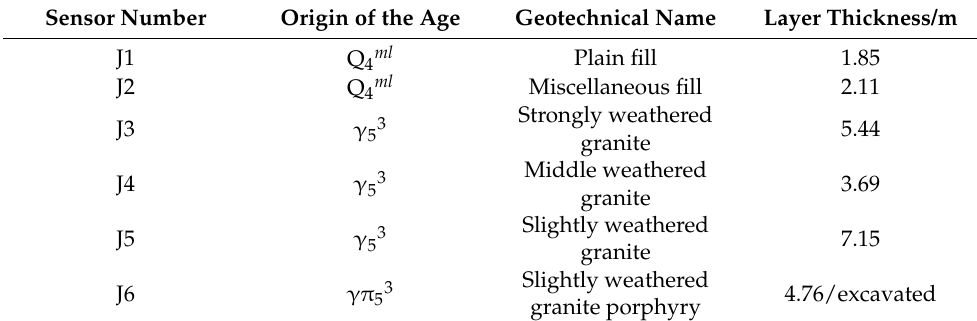
Table 5. Lithology distribution of surrounding rock of foundation pit in